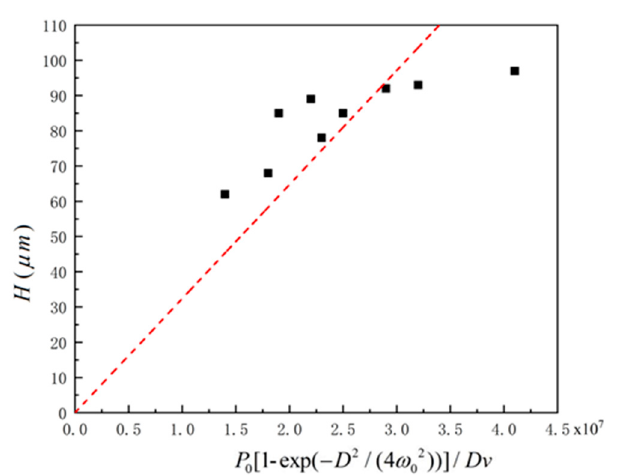
Figure 10. Fitting diagram of groove depth. ( ▪ is the experimental data points, red dot line is the fitted line).